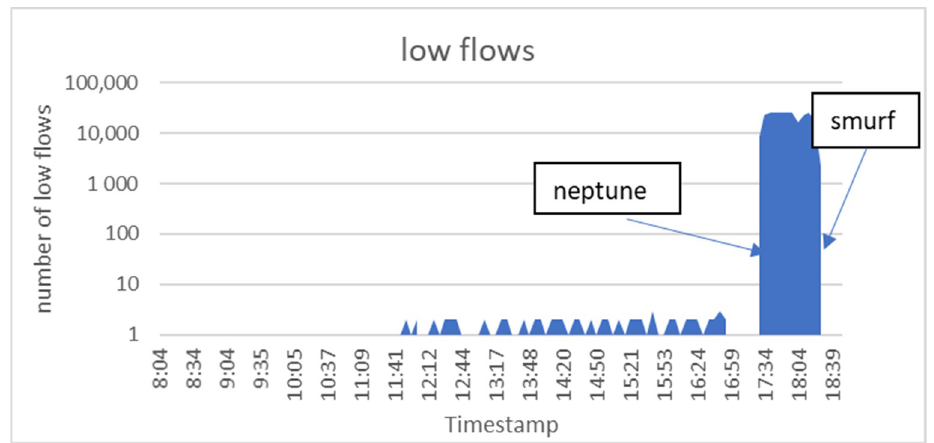
Figure 5. Number of low flows per timestamp for the Friday_1998 dataset.